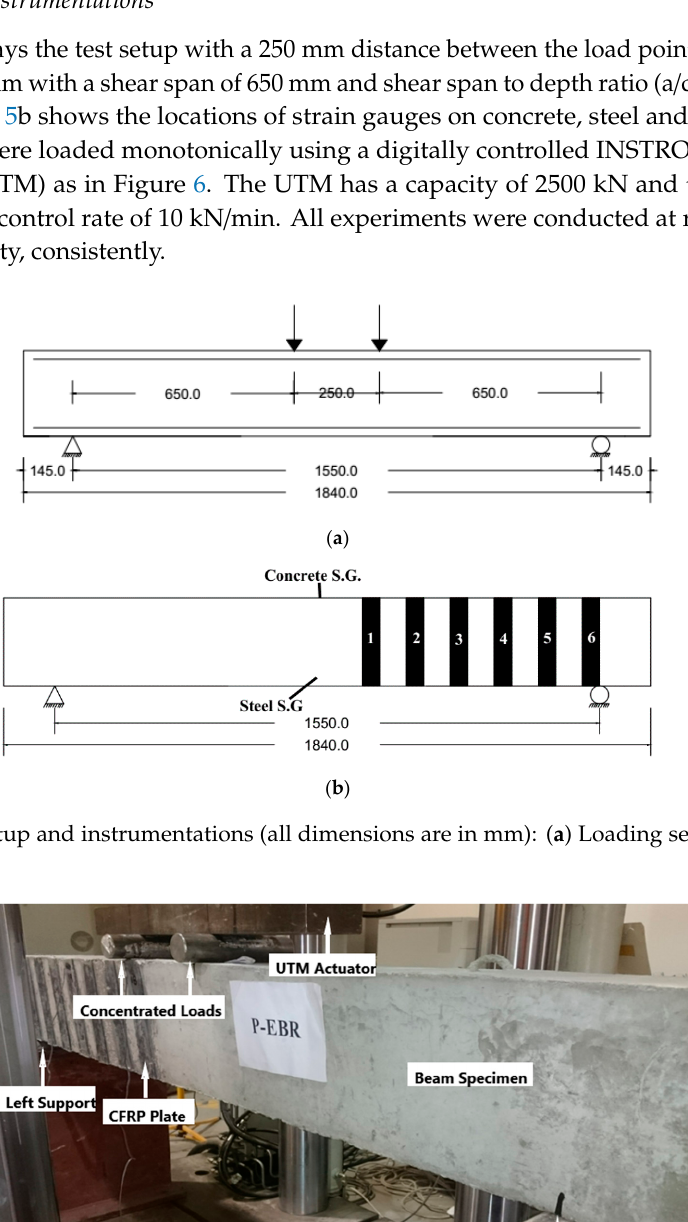
Figure 4. Specimen preparation: ( a ) Marking grooves position; ( b ) Engraving thin grooves; ( c ) Engraving medium grooves; ( d ) Placing CFRP plates and sheets.